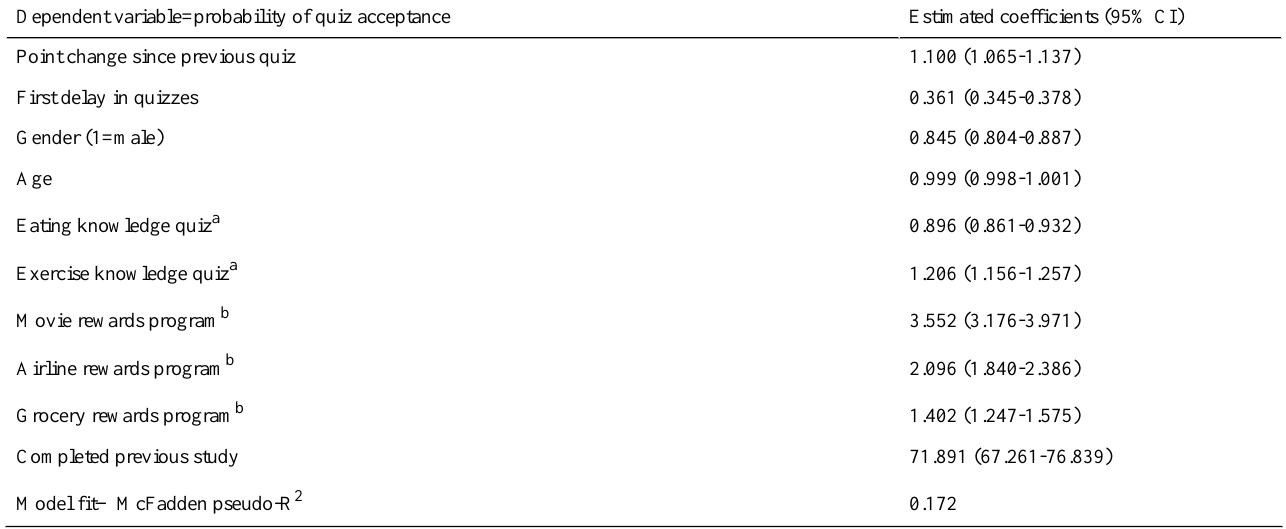
Table 4. Regression results (N=383,719 observations of 54,917 individuals, with 95% CIs in